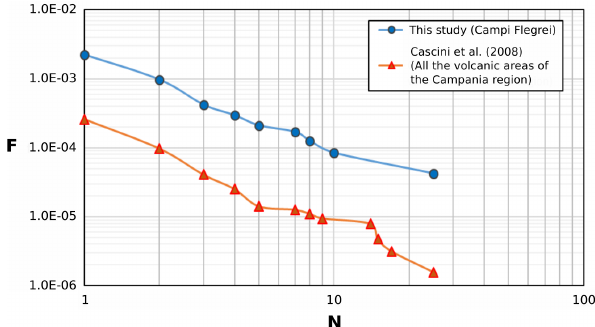
Figure 10. F – N curve of the Campi Flegrei study area compared with the F – N curve developed by Cascini et al. (2008) for a larger area of the Campania region, encompassing the Campi Flegrei, Vesuvius, and Roccamonfina volcanic sectors. F is the annual fre- quency of events causing N or more fatalities. The two curves have been normalized for the areal extension of the investigated areas (1741km 2 for the whole volcanic areas of the region and 230km 2 for the Campi Flegrei study